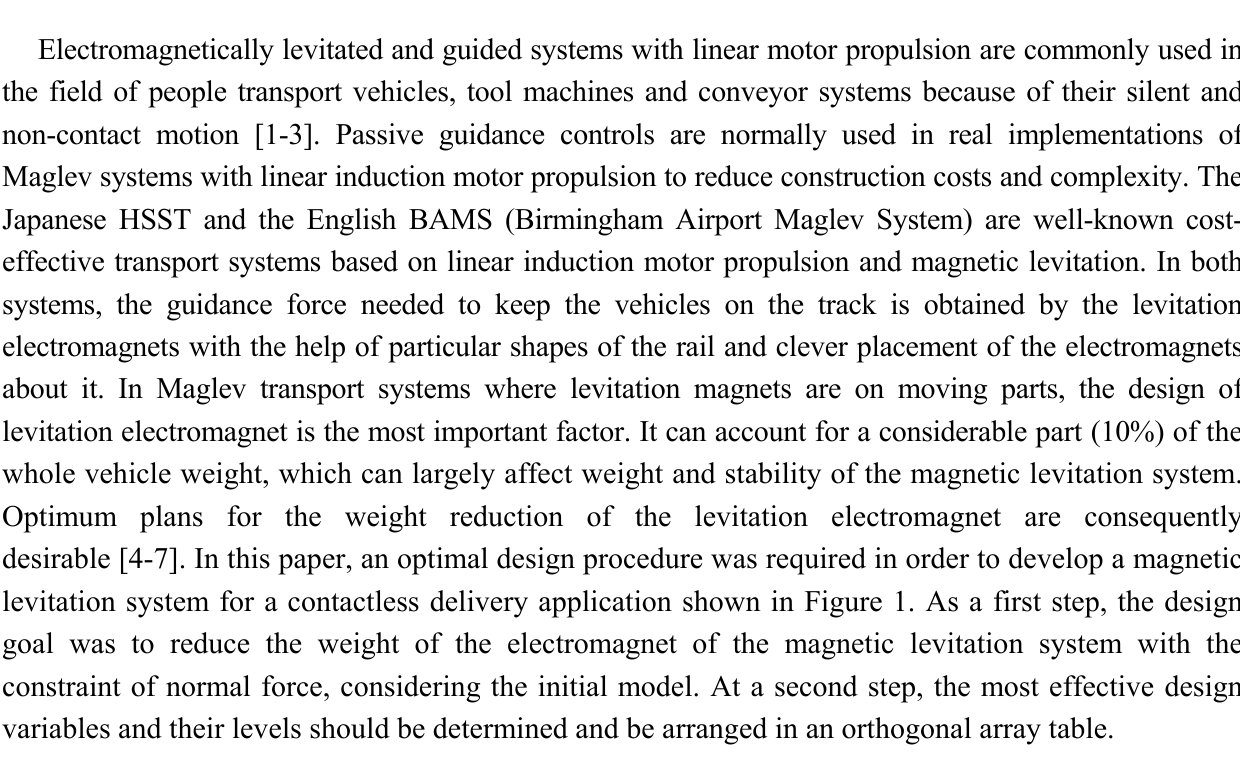
Figure 1. Magnetic levitation system prototype for contactless delivery application: (a) 3D modeling (b)